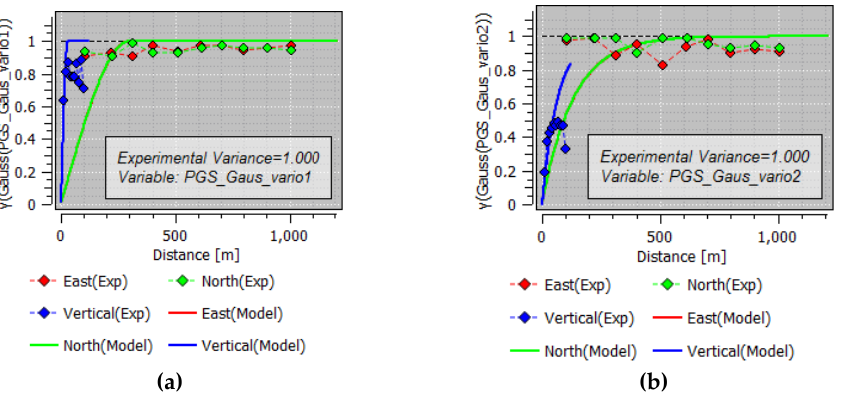
Figure 8. Lithological rule.